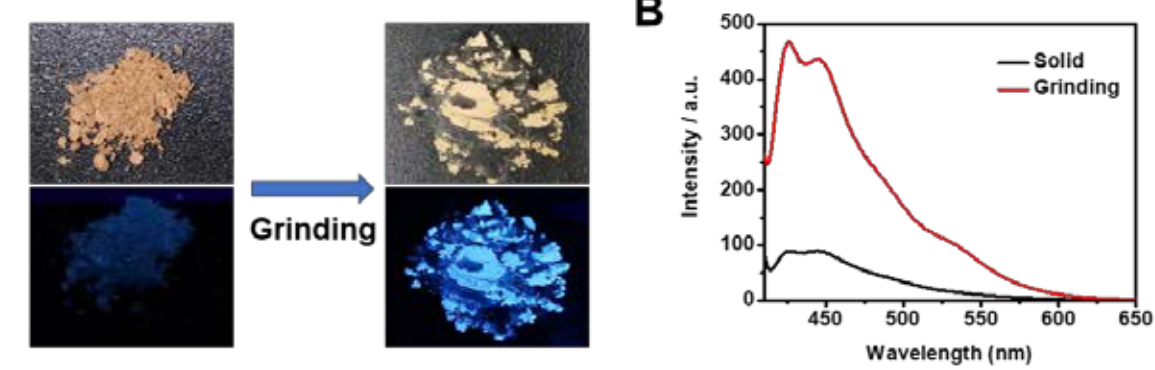
Figure 3. ( A ) Digital images of Py-NBN-Ph at a solid state and after grinding (under sunlight and UV light at 365 nm); ( B ) Emission spectra at a solid state before and after grinding (excited at 398 nm).